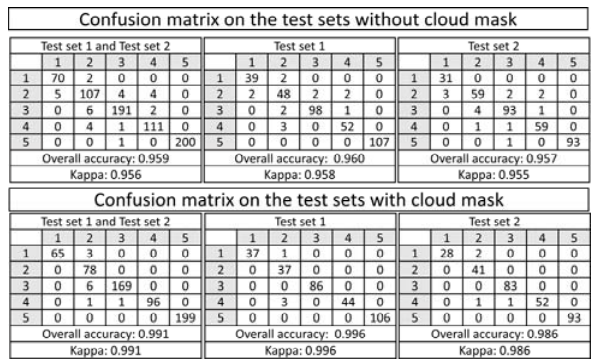
Figure 8. Confusion matrix and accuracy statistics of the solution provided by the Debrecen